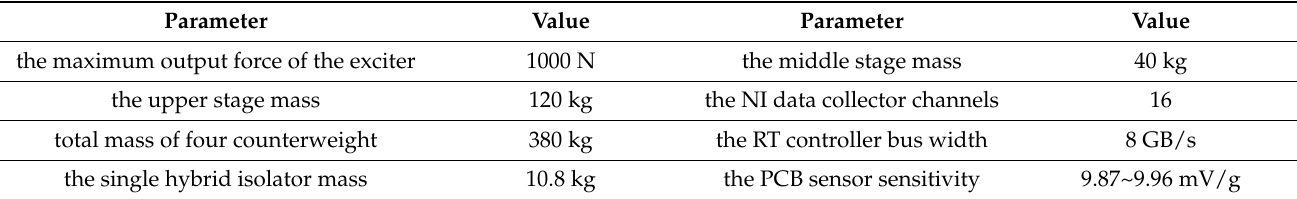
Table 2. Parameters of two-DOF active-passive hybrid vibration isolation